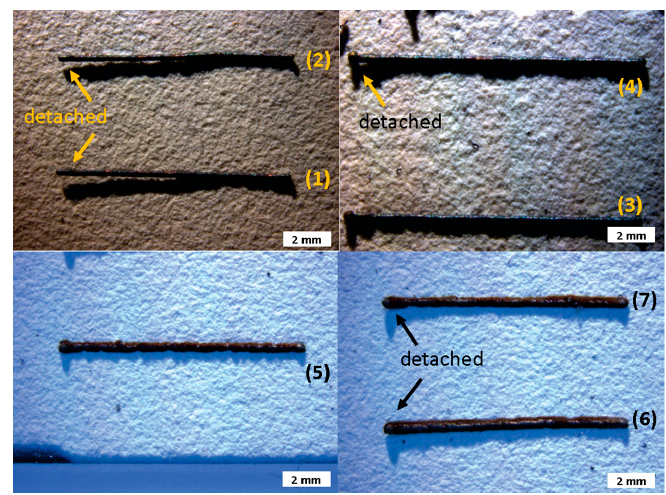
Figure 6. Stereo micrograph of cladded tracks: ( 1 – 4 ) chromel feedstock; ( 5 – 7 ) alumel feedstock. P L = 15 W, v S = 1000 mm/min, d S = 156 μ m, f C = f P = 10 L/min. ( 1 ) f F = 8.1 g/min; ( 2 ) f F = 7.5 g/min;